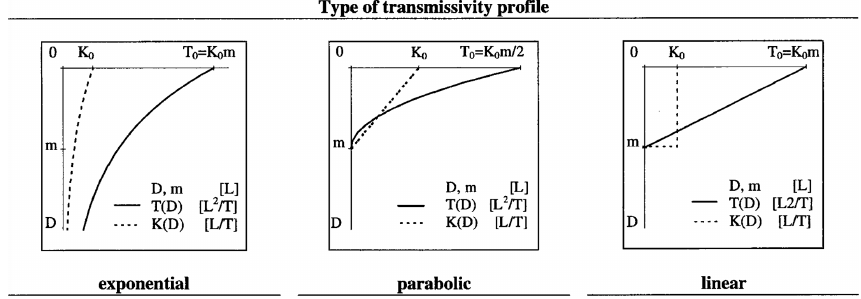
Figure 7. The different types of transmissivity profile considered in Ambroise et al. (1996a, with permission from the American Geophysical Union). Note that plotting recession discharges against time for the exponential profile 1 /Q b should plot linearly. For the parabolic profile, √ Q b should plot linearly (for generalisation to a power law function, see Iorgulescu and Musy, 1997; Duan and Miller, 1997), and for the 1 / linear profile, ln Q b should plot linearly (see Ambroise et al.,